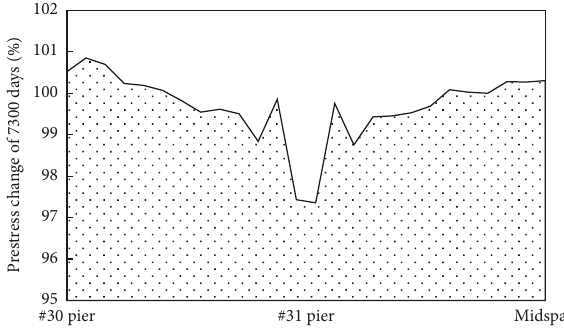
Figure 8: Prestress loss distribution of vertical prestress (half